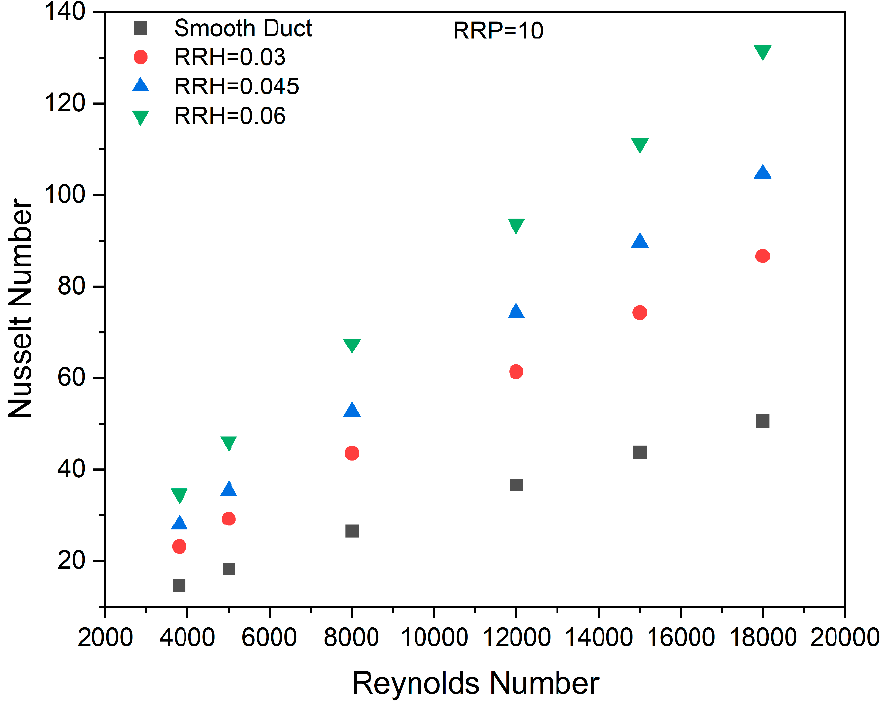
Figure 14. Nu r versus Re .